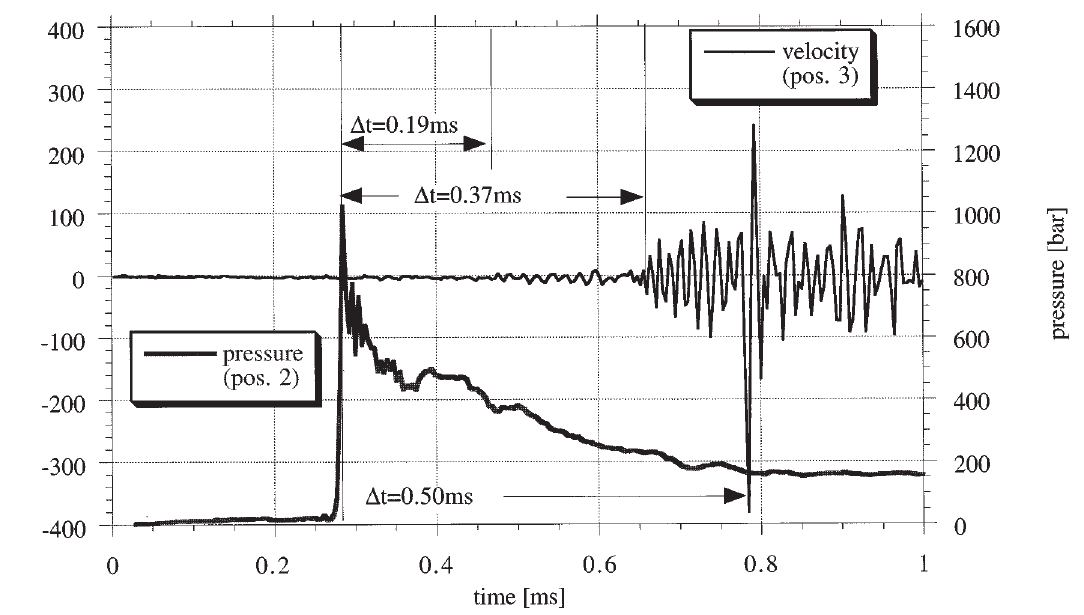
Fig. 5. Time series of pressure and vibration